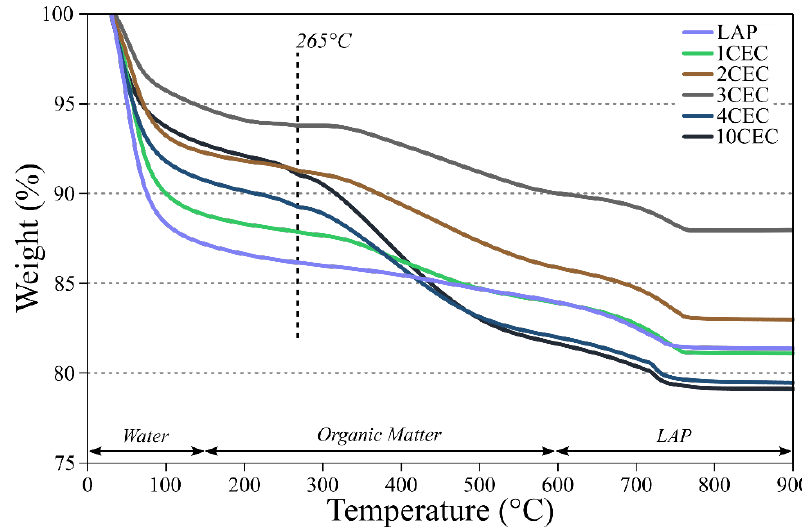
Figure 2. TG curves of LAP and LAP-APTES between 30 and 900 °C with a heating ramp of 2 °C·min −1 .